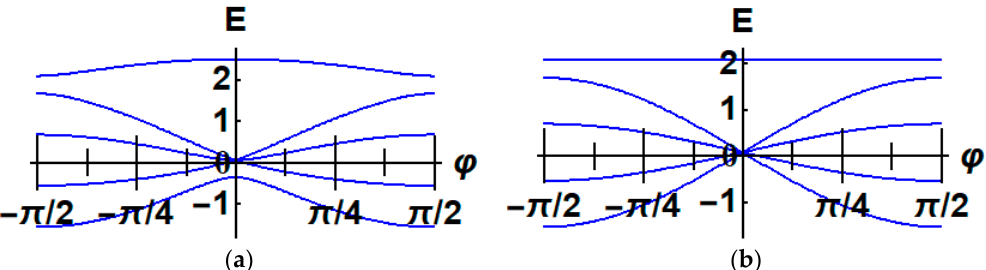
Figure 3. Energy spectrum of four spins in a chain and a second spin interacting with the quantized electromagnetic field. The number of excitations is equal to one. ( a ) Results for the spectrum are the same for the case of spin chain consist of spins 1/2; the case of spin chain consists of spin 1, G 1 = cos ( ϕ ) , and G 2 = 0; the case of spin chain consists of spin 1, G 1 = cos ( ϕ ) and G 2 = cos 2 ( ϕ ) ( b ) spin chain consists of spin 1, G 1 = 0 and G 2 = cos 2 ( ϕ ) .